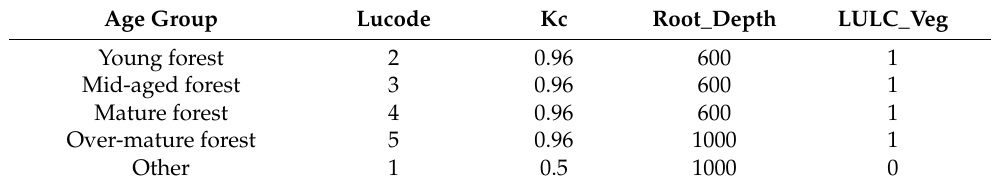
Table 3. Table of the biophysical parameters of PM plantations in the northern tropical case study